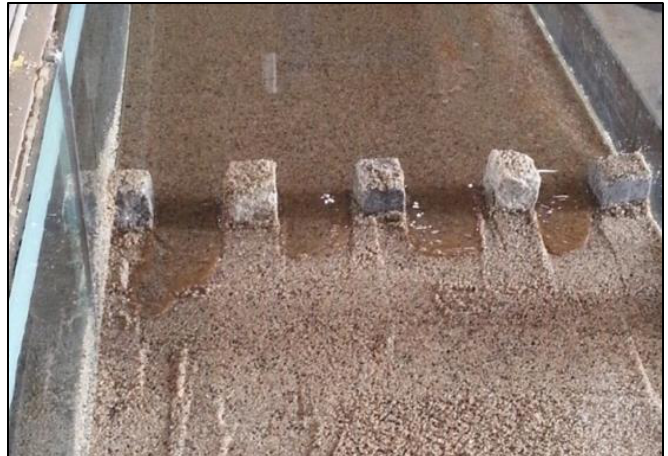
Figure 7. Variant II of the flume development.